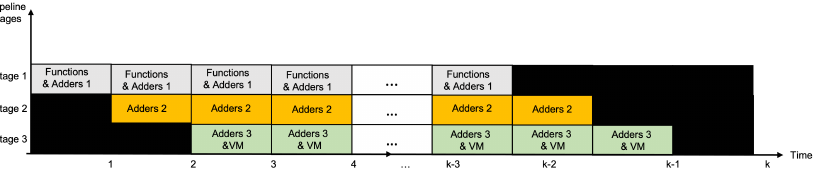
Figure 4. The three stages of the proposed pipeline